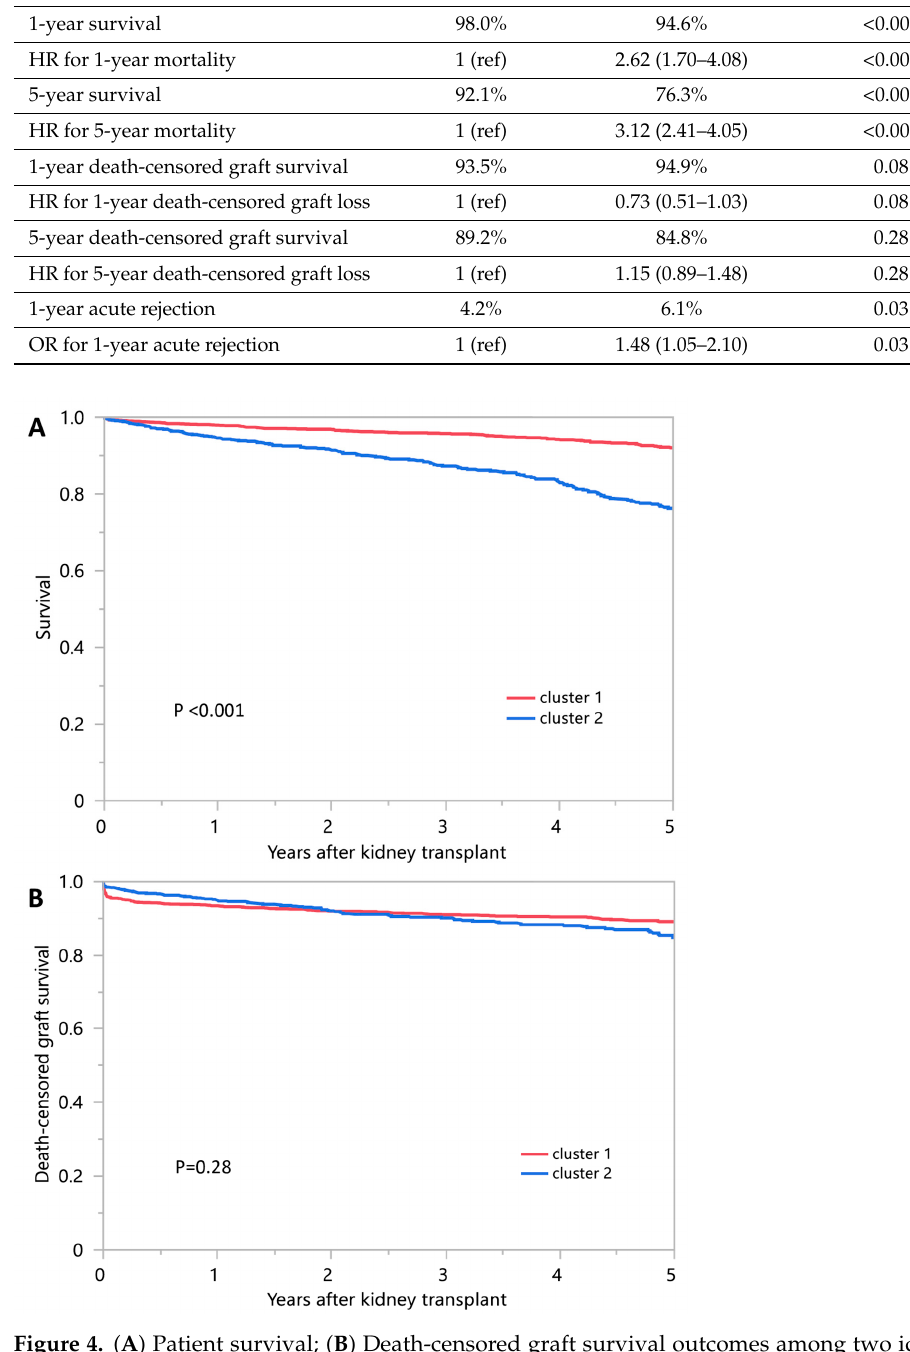
Figure 4. ( A ) Patient survival; ( B ) Death-censored graft survival outcomes among two identified clusters of DKT patients.